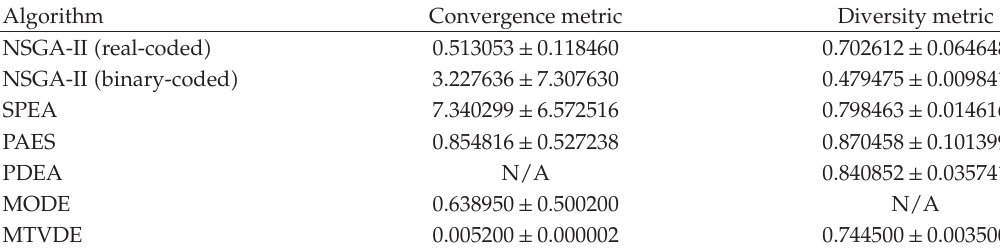
Table 4: Testing result’s statistics of the problem ZDT4.